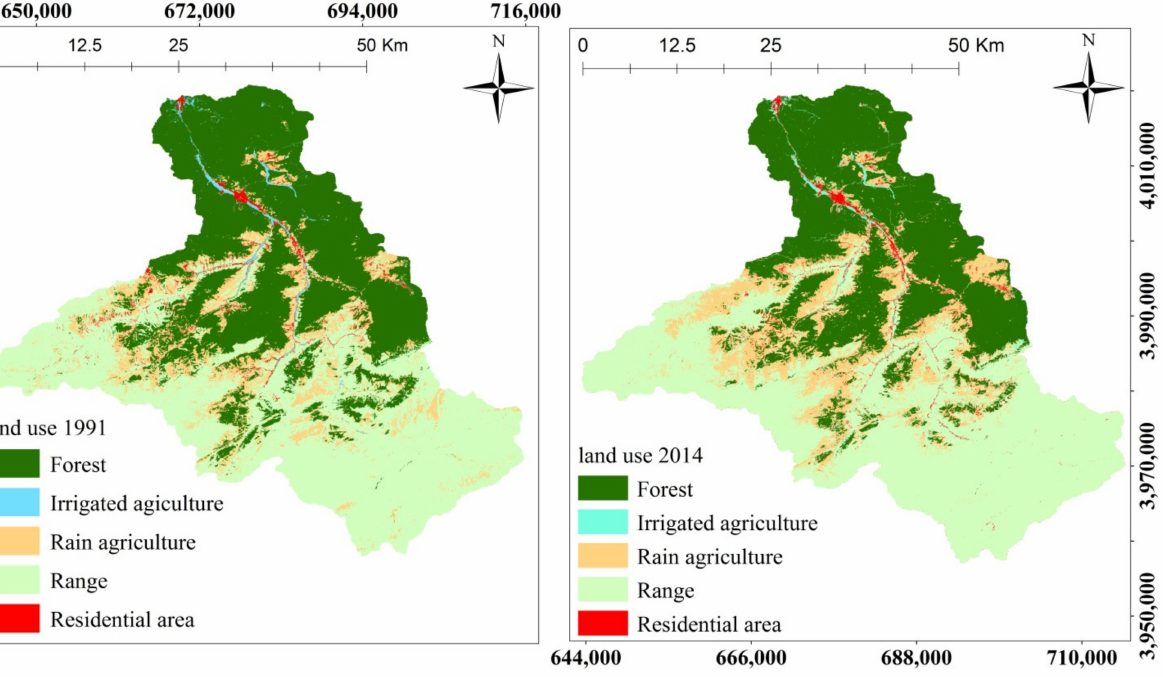
Figure 4. Land use maps of Talar watershed for the year 1991 ( left ) and 2014 ( right